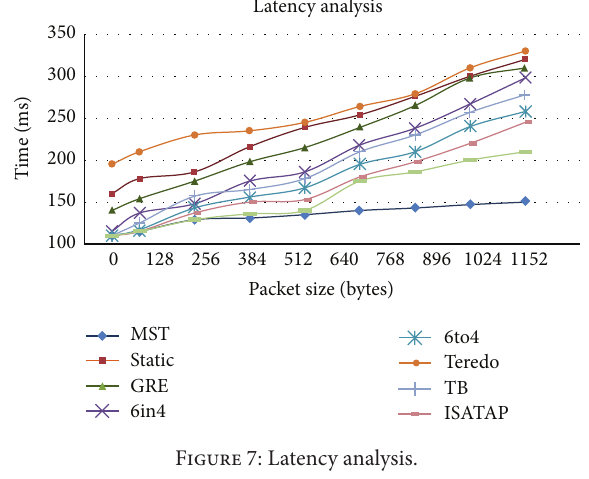
Figure 6: Round trip time (RTT).